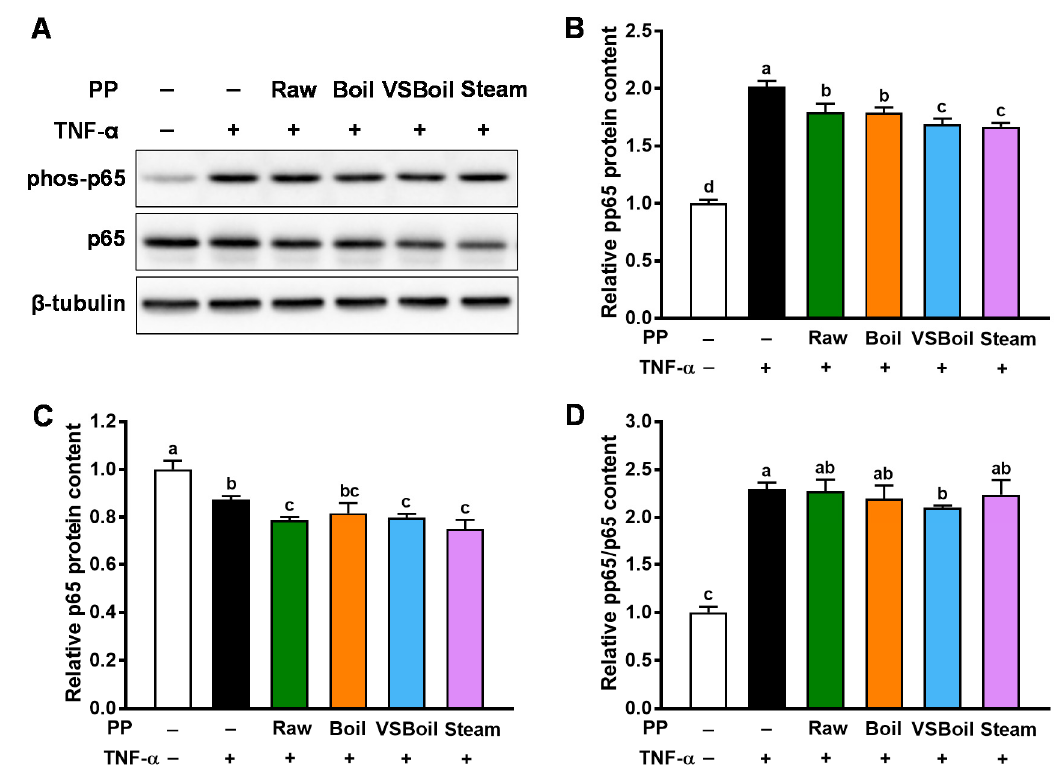
Figure 5. Anti-inflammatory effects of purple potato (PP) extracts on human colonic Caco-2 cells treated with tumor necrosis factor (TNF)- α . ( A ) Representative immunoblotting bands; ( B ) phospho-p65; ( C ) total p65; ( D ) ratio of phospho-p65 to p65. VSBoil: vacuum-seal boiling. a–c means among bars without common letters differ significantly at p < 0.05 (mean ± SEM, n = 4).